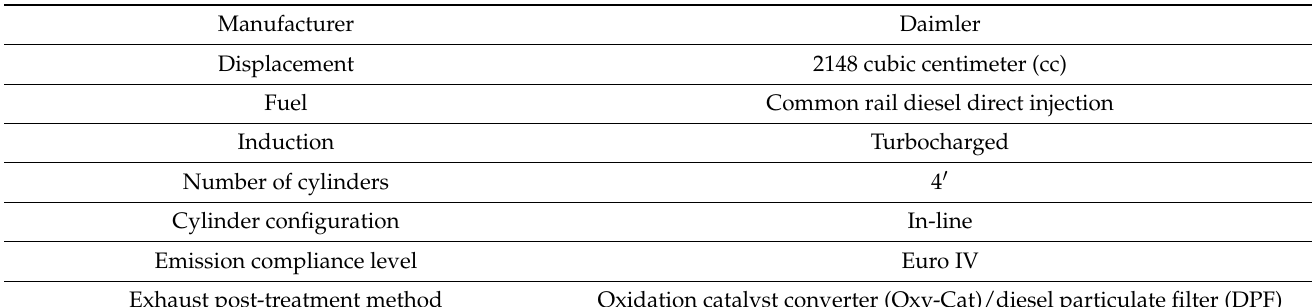
Table 3. OM646LA diesel engine